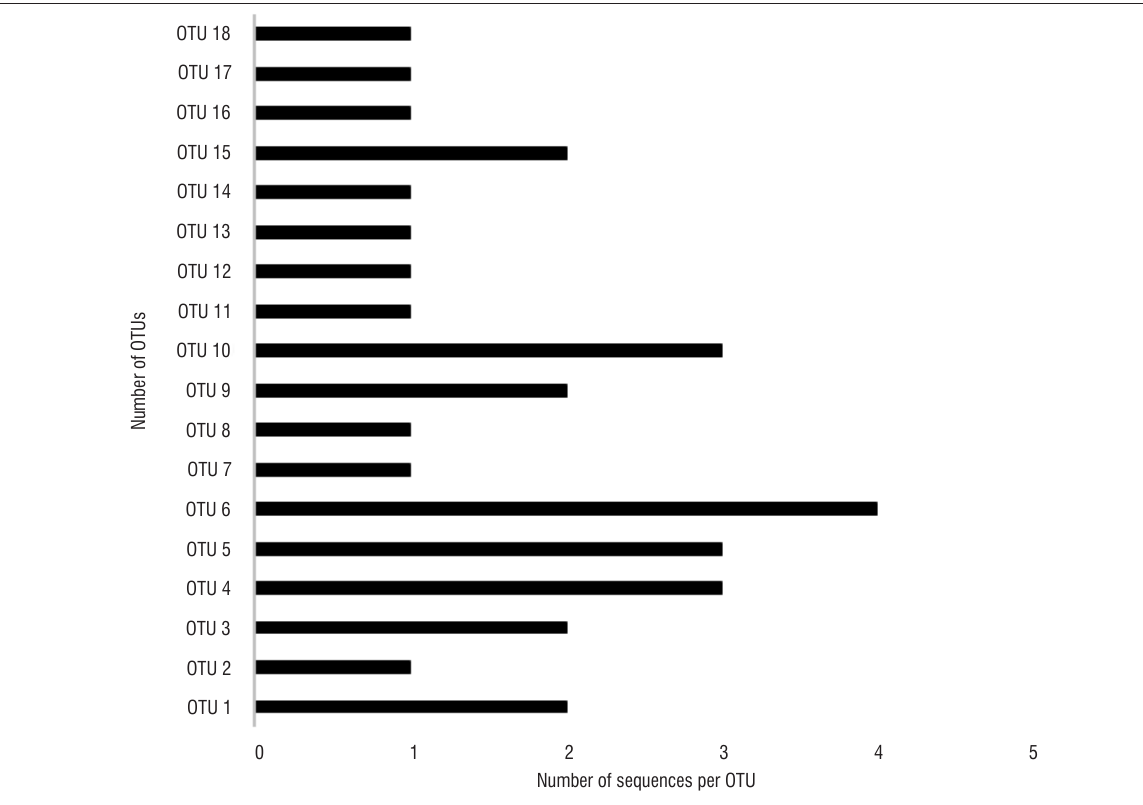
Figure 2: Operational taxonomic units (OTUs) of 16S bacterial sequences obtained from 90-day-old Bt and non-Bt maize